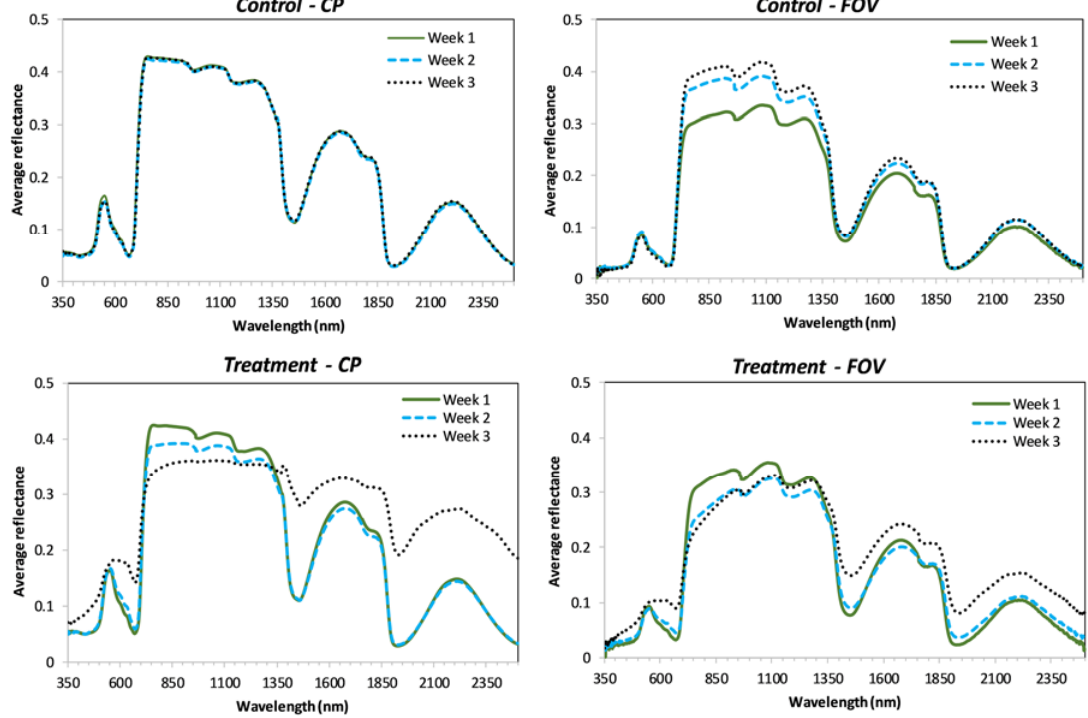
Figure A1. Control and treatment spectra for A. thaliana as acquired by CP and FOV.